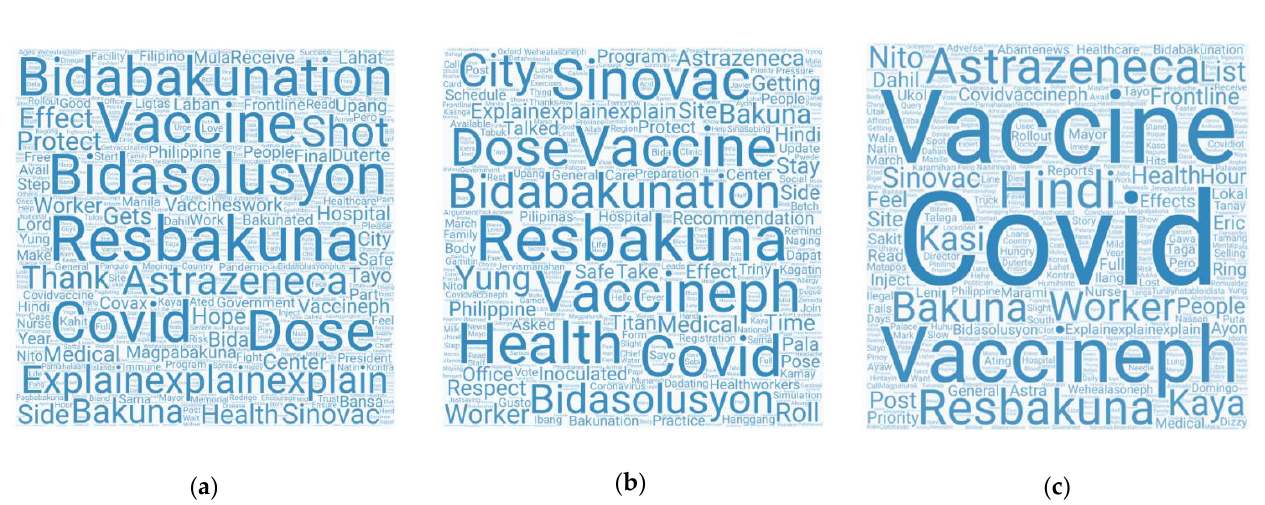
Figure 9. Word cloud: ( a ) positive polarity, ( b ) neutral polarity, and ( c ) negative polarity. The word cloud displays the words used in the dataset; the more frequently the word was used, the bigger it is displayed in the word cloud. Table 6. Word count per classification.